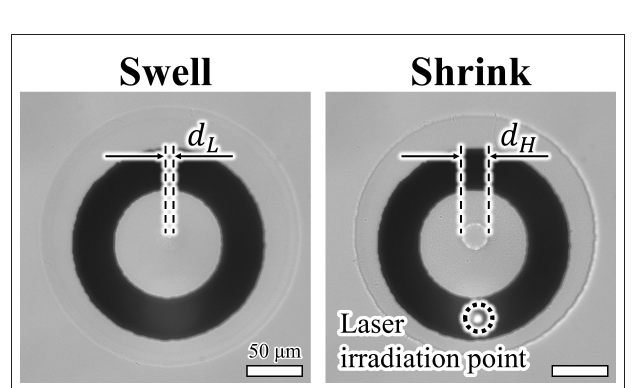
FIGURE 6 | Microscopic image of a driven microactuator.